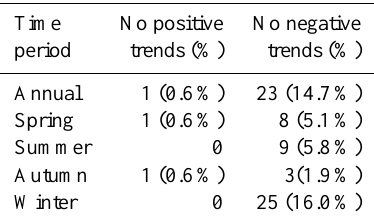
Table 1. Number and proportion of series with significant trends, significance level α = 0 .